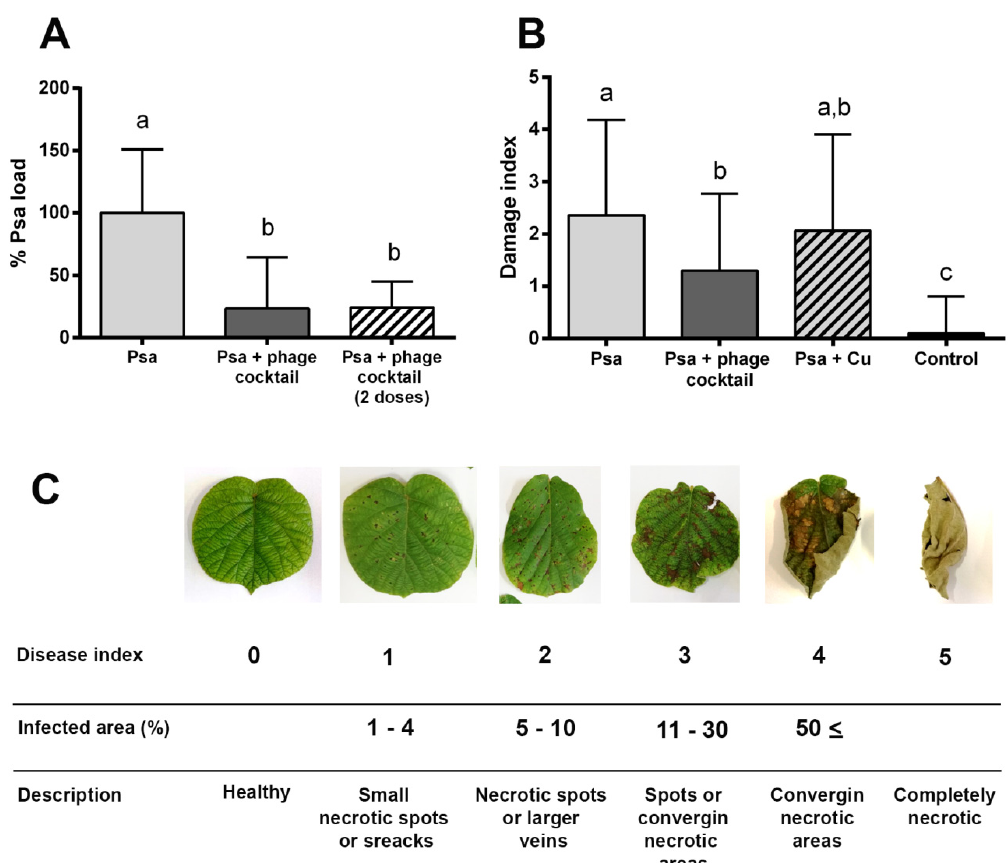
Figure 5. E ffi cacy of Chilean Psa phages to control Psa in vivo. ( A ) Bacterial Psa load reduction in kiwifruit leaves treated with phages 24 h post-infection with Psa. Phages were added 1 h (Psa + phage cocktail) or 1 and 24 h (Psa + phage cocktail (two doses)) post-infection with Psa. ( n = 5 leaves per condition). ( B ) Average damage index of two independent experiments performed with kiwifruit plants ( A. chinensis var. deliciosa “Hayward”) maintained in greenhouse conditions. Kiwifruit plants were infected with Psa alone (light grey), infected with Psa and treated with phage cocktail (dark grey), or infected with Psa and treated with copper sulfate (Cu) (striped bars). The control plants were uninfected and were not treated with phages or copper. The phage cocktail corresponded to an equal mixture of CHF1, CHF7, CHF19, and CHF21 and was added once with a MOI of 10, 1 h post-infection with Psa. The symptomatology in kiwifruit plants was evaluated 30 days post-infection. Five plants for each treatment and five leaves per plant were used in each experiment. Standard deviation bars are shown. The letters indicate significant di ff erences using one-way ANOVA and Tukey’s multiple comparisons test ( p ≤ 0.05) ( n = 50). ( C ) The visual pattern of the damage index